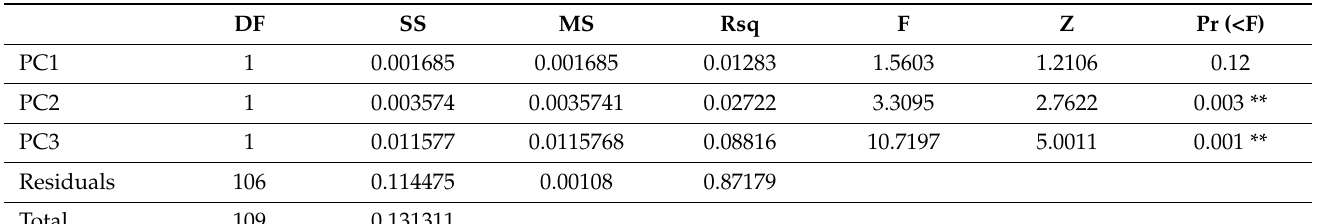
Figure 6. Partial least squares analysis of the body shape of C. kraussii and the environmental parameters of temperature, pH and dissolved oxygen (DO). The first horizontal of the graph Block 1 PLS1 contains shape, and the vertical axis Block 2 PLS1 contains the environmental variables. The colors represent localities: red: UEP1; green UEP2; grey UEP4; blue: UEP9. Table 1. ANOVA to estimate the effect on shape of the first three PC of ecological variables on shape ** represent highly significant